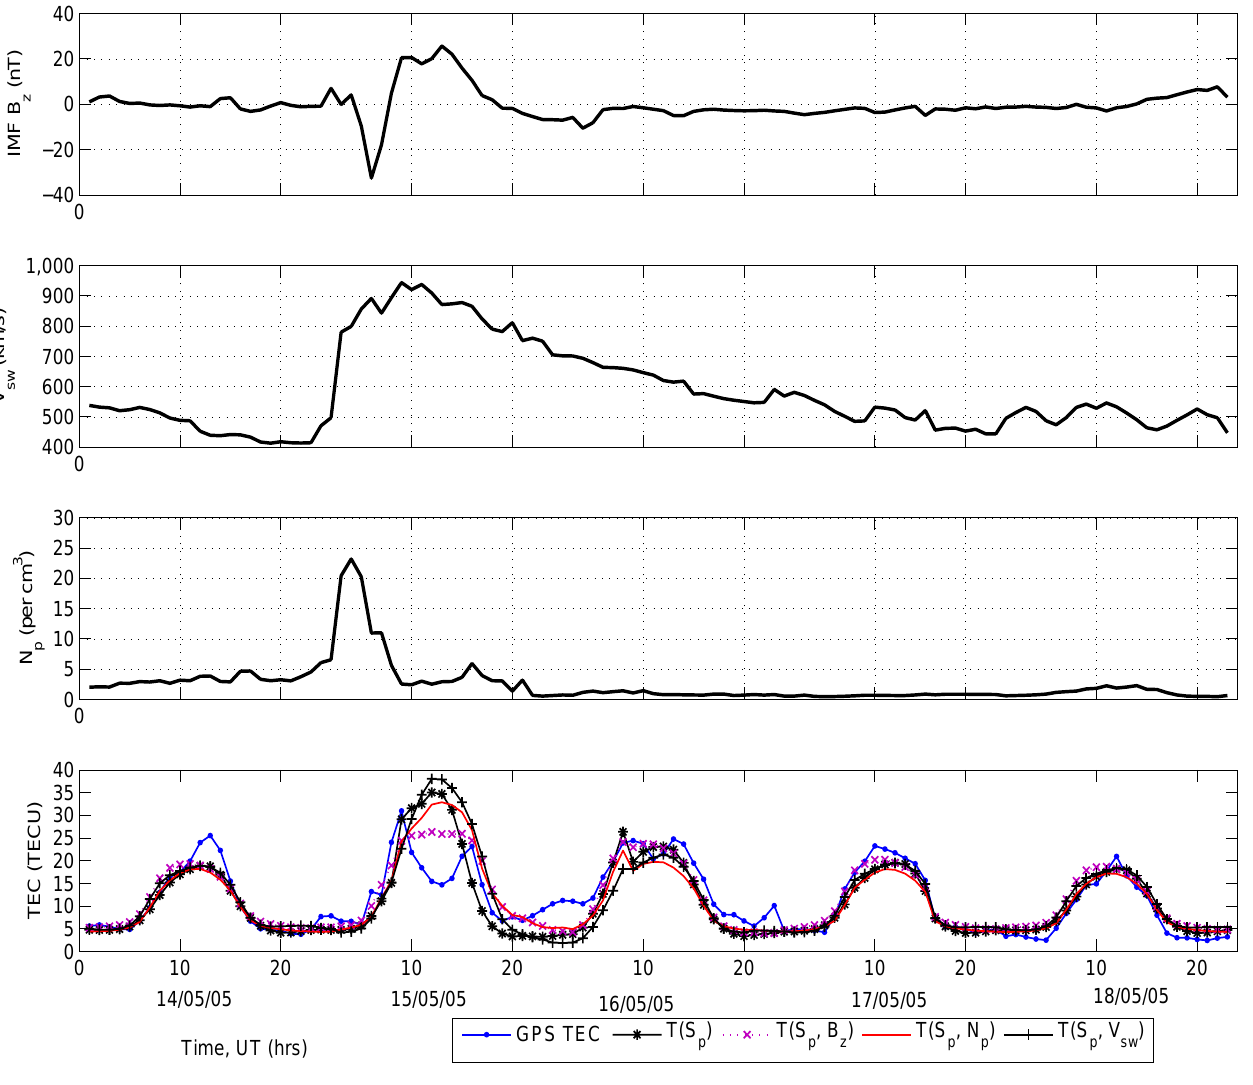
Fig. 8. Variations of the considered solar wind parameters and TEC values (derived and predicted) during 14–18 May 2005.